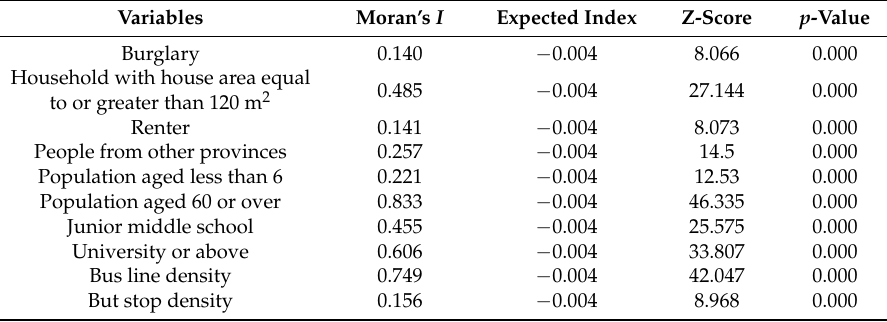
Table 5. Moran’s I Statistics for Explanatory